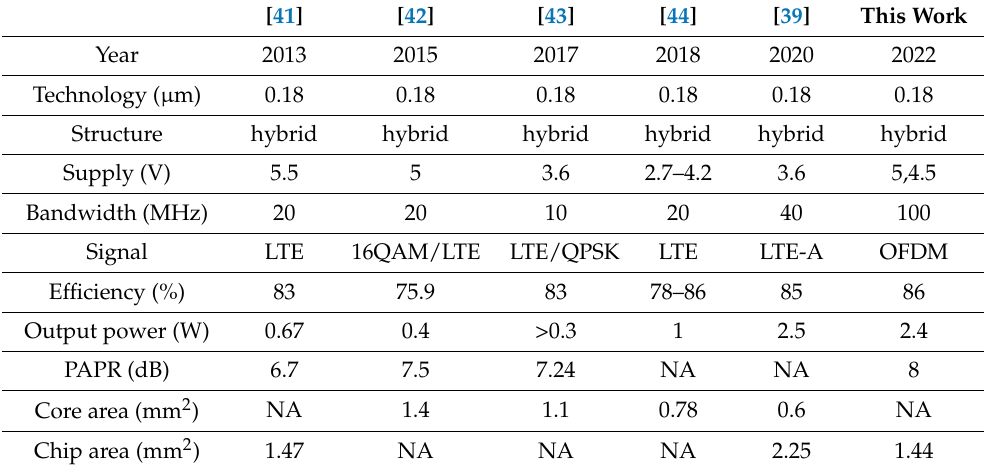
Table 1. Comparison of power supply